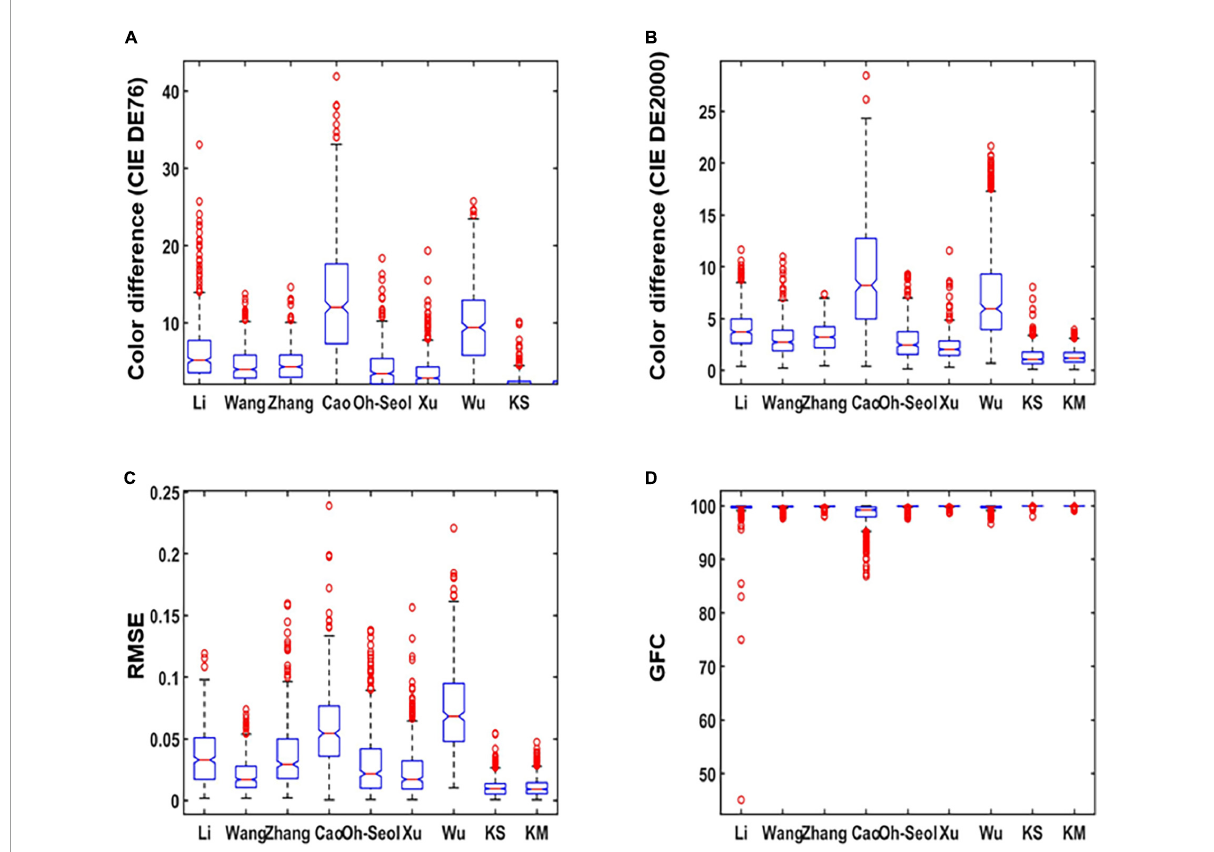
FIGURE8 Boxplots of real experiment results: (A) The International Commission on Illumination (CIE) DE1976 color difference, (B) goodness of fit coefficient (GFC) CIE DE2000 color difference, (C) root-mean-square error (RMSE), and (D)